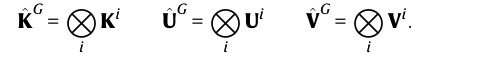
Fig. 2 | Architecture of an iVAMPnet for N subsystems, where trainable parts are shaded green. Two lobes are given for con fi guration pairs x t (light) and x t + τ (dark) where the weights are shared. Firstly, the input features are element wise weighted (cid:2) Y t = G (cid:3) x t with a mask G 2 R D × N , where each subsystem learns its individual weighting. The mask values can be interpreted as probabilities to which subsystem the input feature belongs. In order to prevent the subsequent neural network to reverse the effects of the mask, we draw for each input feature i and subsystem j an independent, normally distributed random variable